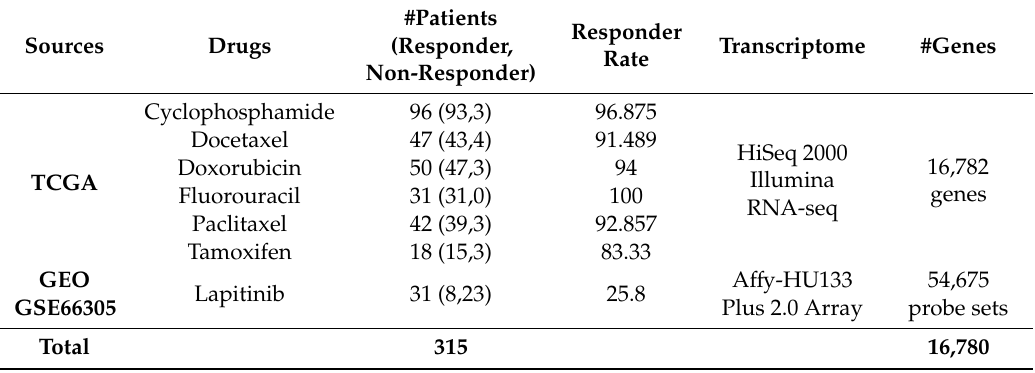
Table 1. Transcriptome before drug treatment and patient drug response after drug treatment, collected from The Cancer Genome Atlas (TCGA) and Gene Expression Omnibus